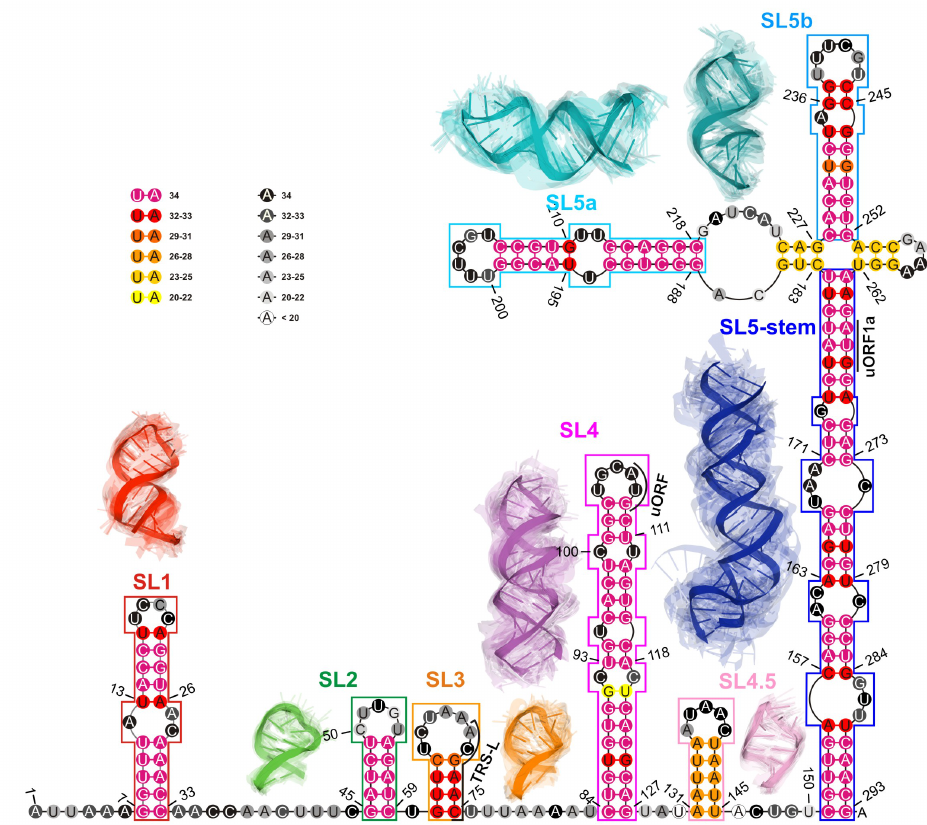
Figure 3. The consensus-driven secondary structure for the 5 (cid:48) -UTR region. Domains: SL1 (red), SL2 (green), SL3 (orange), SL4 (magenta), SL4.5 (light purple), SL5 stem (blue), SL5a (cyan), and SL5b (deep teal). Paired regions are coloured according to the preservation of base pairs in all considered 3D RNA models, from magenta (paired in 100% of models) to yellow (paired in ≥ 50% of models). Unpaired regions are coloured according to the probability that a given residue is not paired in all analysed models, from black (unpaired in 100% of models) to white (unpaired in ≥ 50% of models). Regions are bordered according to their colouring in 3D models. The centroid of each cluster is solid; the remaining cluster members are